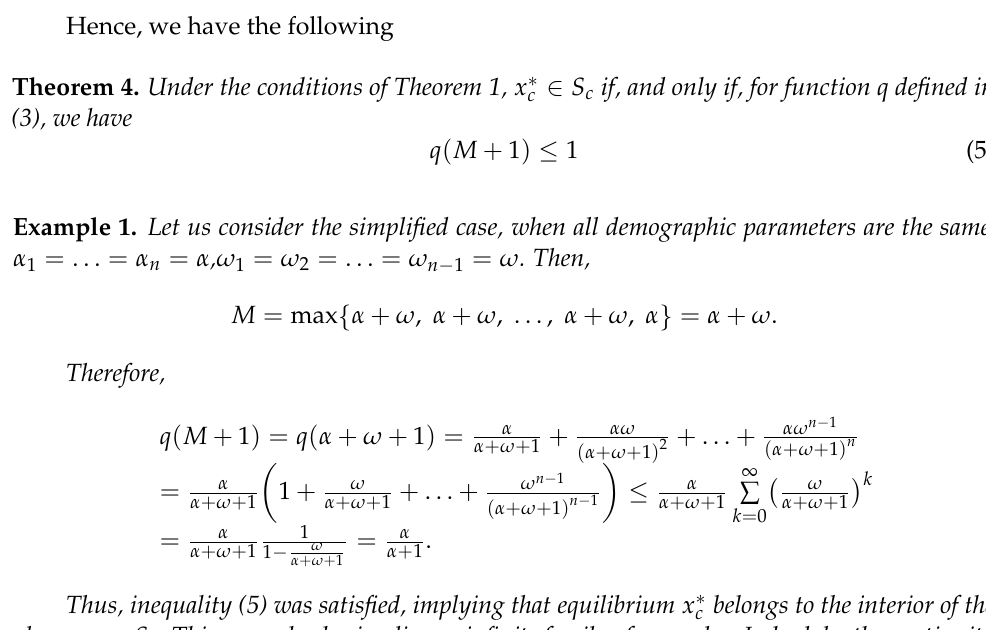
Figure 1. Strictly decreasing function q with lim q ( M + 1 ) ≤